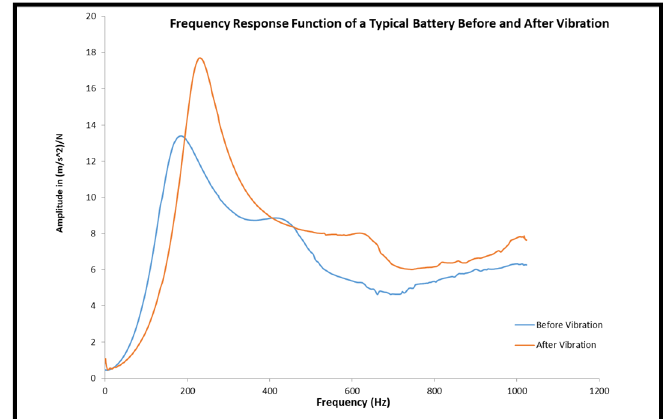
Figure 14. Typical FRF curve for cell before and after vibration.